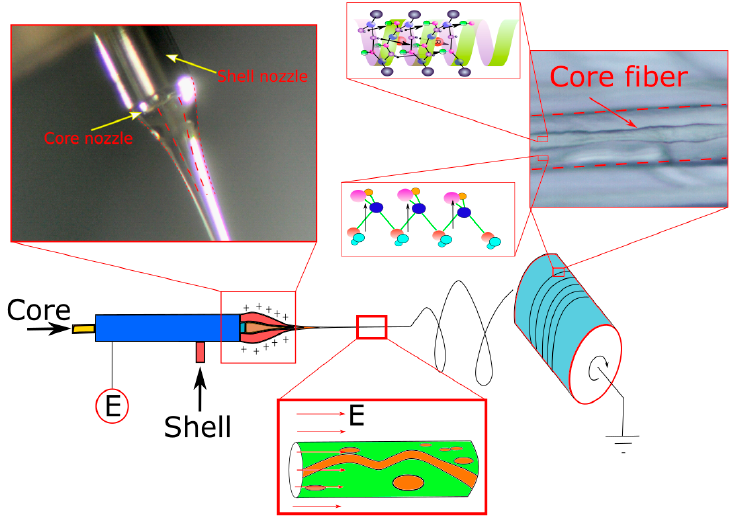
Figure 2. Schematic principle of fabrication of PBLG/PVDF core–shell fibers by electrospinning. The core solution is PBLG/DCM, the shell solution is PVDF/DMF–acetone. The external voltage (E) is from 16 to 20 kV.